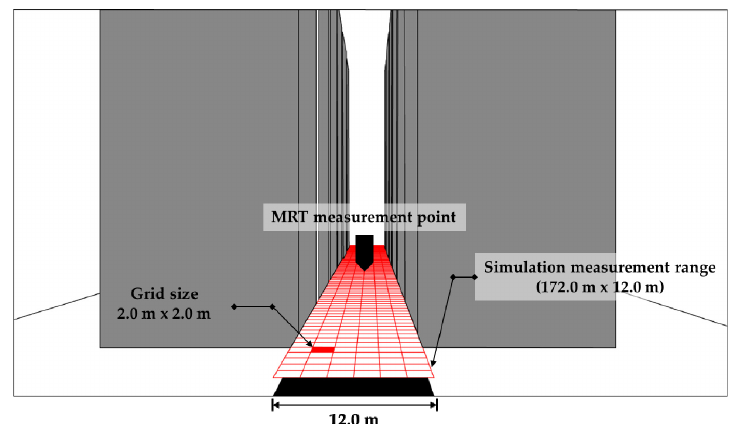
Figure 4. Simulation measurement range.